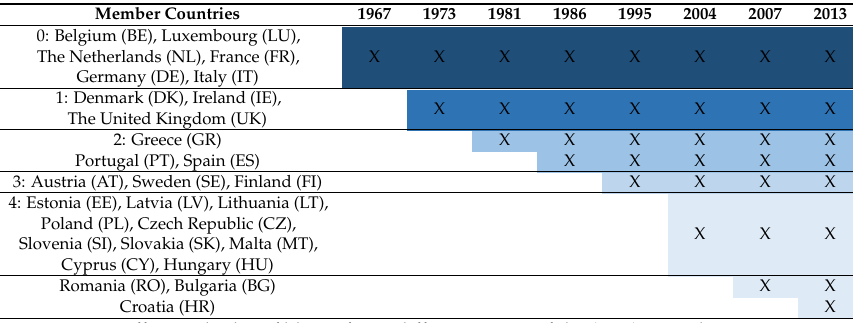
Note: Different shades of blue refer to different stages of the (pre-) EU enlargement.